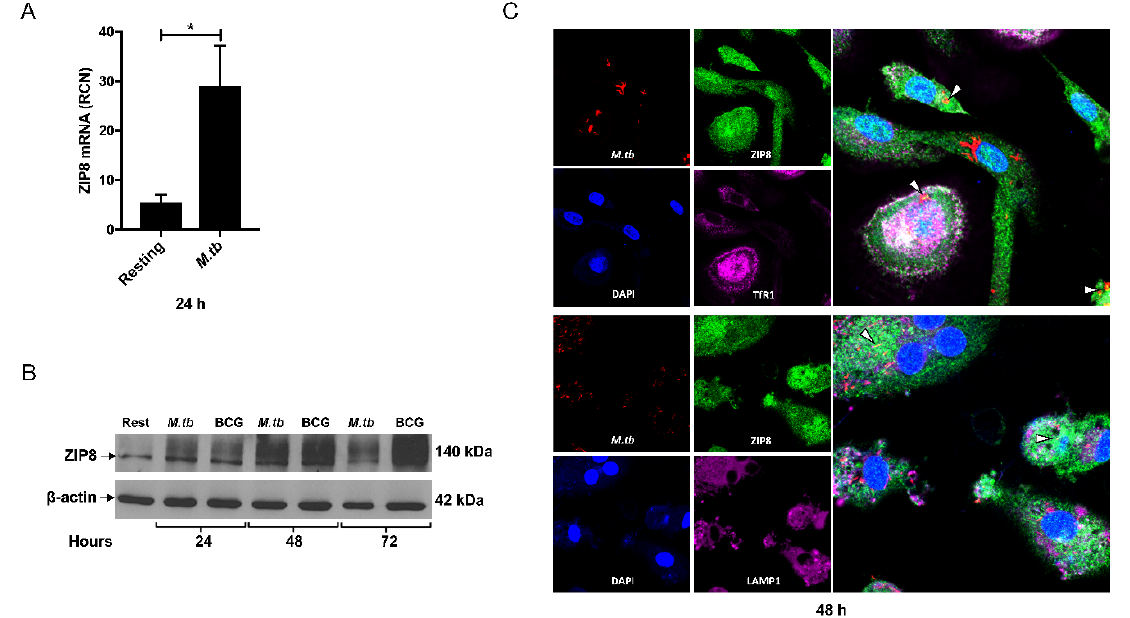
Figure 2. ZIP8 protein is induced and localizes with M.tb in human macrophages. MDM production of ZIP8: ( A ) mRNA is significantly induced for 24 h, following infection with M.tb H 37 R v (MOI 5:1), as determined by qRT-PCR relative to GAPDH ( n = 3) and ( B ) ZIP8 protein is robustly increased by infection with M.tb H 37 R v or M.bovis BCG (MOI 5:1) between 24 and 72 h, as determined by Western blot relative to β -actin ( n = 3). ( C ) The infection of MDMs with mCherry expressing M.tb H 37 R v (MOI 5:1) for 48 h leads to the extensive co-localization of ZIP8 with M.tb (yellow; indicated by arrow heads) and TfR1 (abundant white; in merged upper panel) but very limited co-localization with LAMP-1 (negligible white; in merged lower panel) (A, B, and C are unpublished data) (mean ± SEM; * p < 0.05; Prism-7: one-tailed Students t -test). MDM isolation, culture, and infection [54]; qRT-PCR and Western blot of ZIP8 in MDMs [56]; and confocal fluorescence microscopy using an Olympus FV1000-Spectral System at 60 × magnification in infected MDMs [67] were performed as previously described. Rabbit polyclonal antiserum anti-peptide to amino acid residues 225 to 243 of human ZIP8 1 was purchased from Covance (Princeton, NJ, USA). Mouse anti-human monoclonal β -actin (#69101) antibody was purchased from MP Biomedicals (Santa Ana, CA, USA). Mouse anti-human monoclonal CD71 (#334102) antibody was purchased from Biolegend (San Diego, CA, USA). Mouse anti-human monoclonal LAMP-1 (#ab25630) antibody was purchased from Abcam (Cambridge,